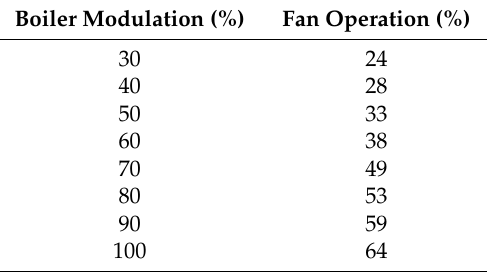
Table 3. Modulation